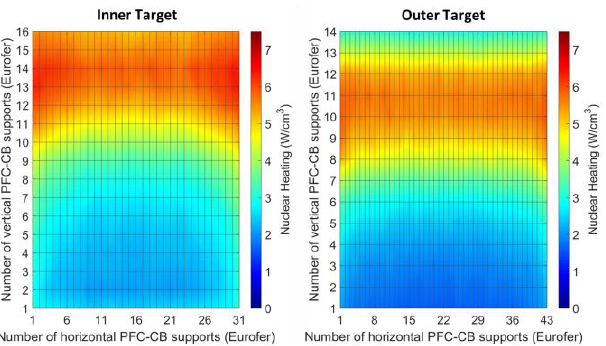
Figure 16. Nuclear heating (W/cm 3 ) distribution on PFC-CB supports (Eurofer) of the inner ( left ) and outer ( right ) target, with HCPB blanket.